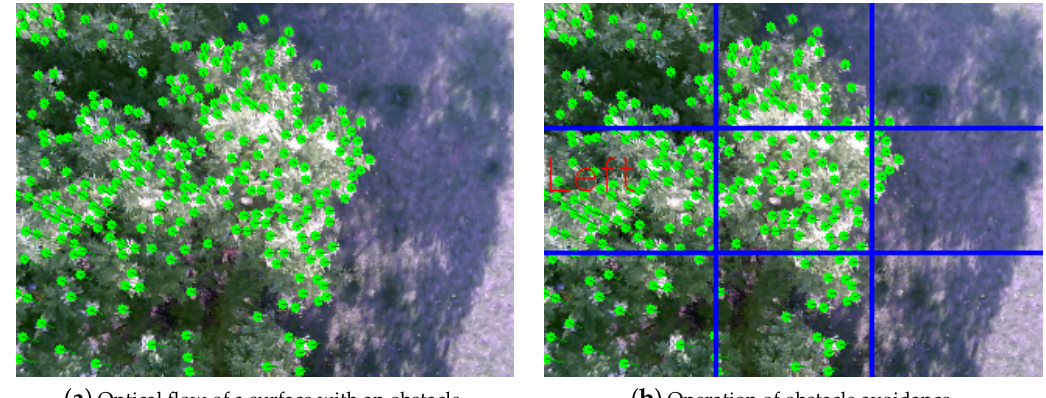
Figure 10. Optical flow magnitude map of obstacle avoidance.